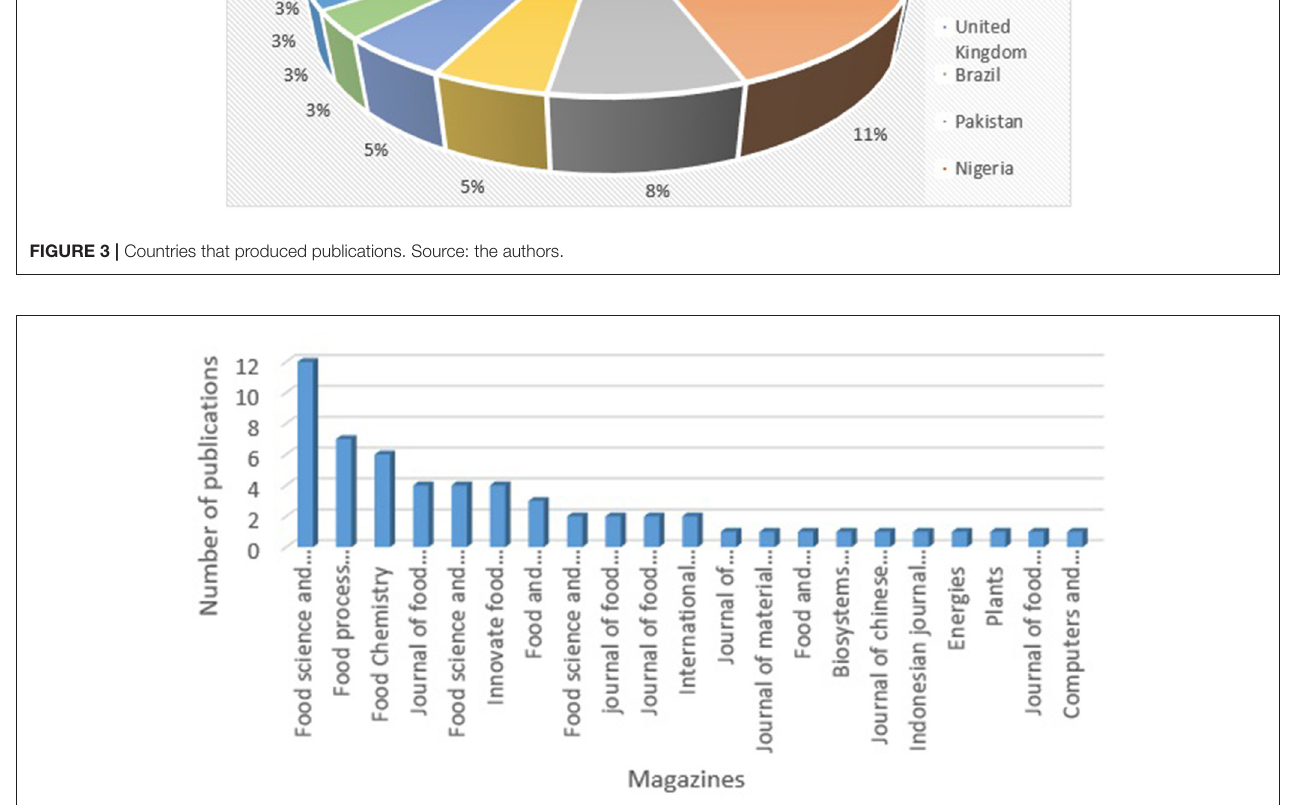
FIGURE 4 | Magazines that made the publications. Source: the